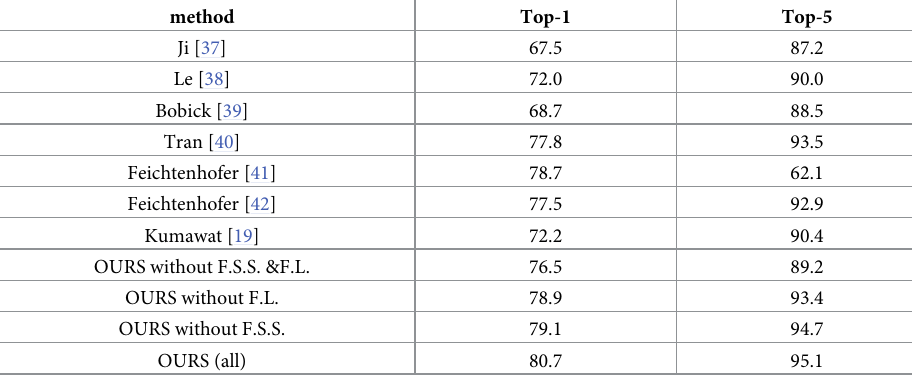
Table 8. Accuracy comparison of different methods in